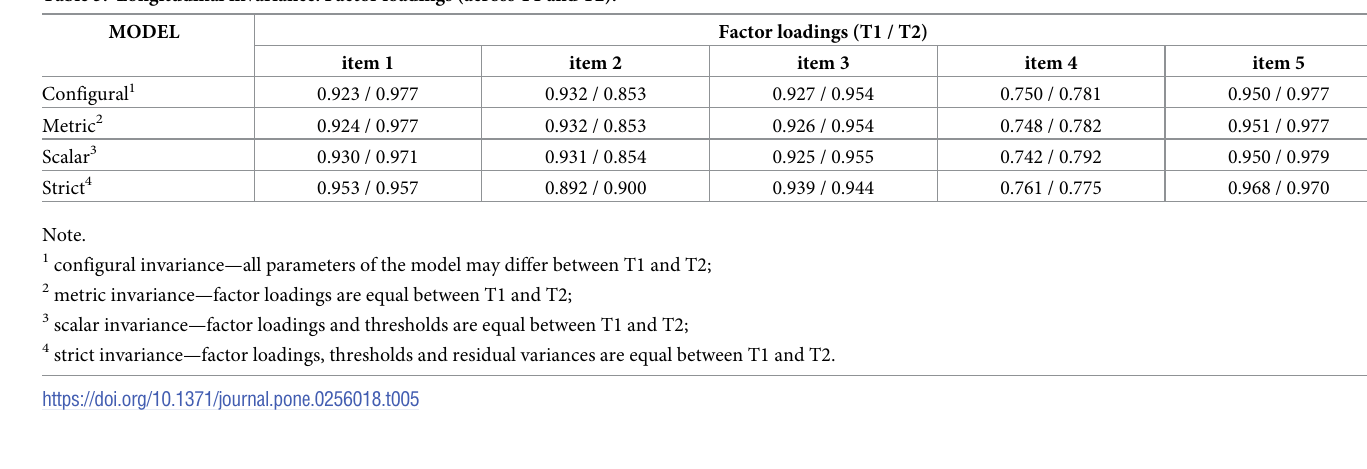
Table 5. Longitudinal invariance: Factor loadings (across T1 and